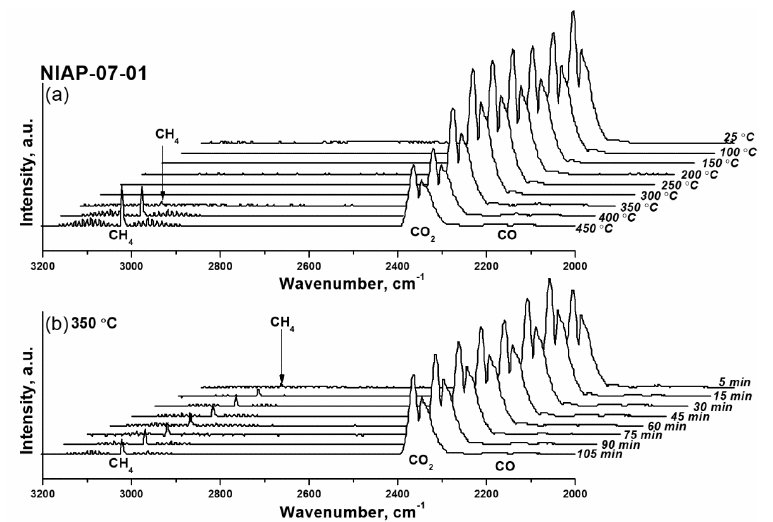
Figure 13. FTIR spectra of the gas at the outlet of the reactor when the industrial NIAP-07-01 catalyst was activated at varying ( a ) the temperature and ( b ) duration of the process. Activation conditions: volume ratio is H 2 :CO 2 :Ar = 16:4:80, and flow rate is 19,000 cm 3 ·g cat − 1 ·h − 1 .